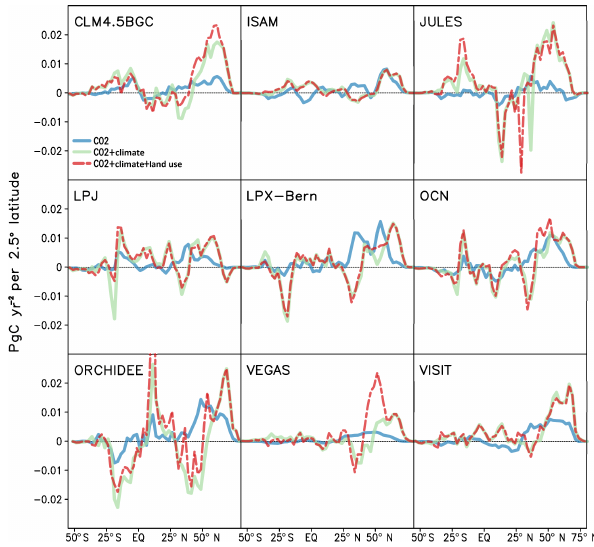
Figure 8. Latitudinal contribution of trends for seasonal amplitude of global land–atmosphere carbon flux from TRENDY models in the three sensitivity experiments. Fluxes are summed over each 2.5 ◦ latitude band (PgCyr − 1 per 2.5 ◦ latitude) before computing the F i (refer to the Methodology section for definition). For each 2.5 ◦ k A latitude band, the trend is calculated for the period 1961–2012.